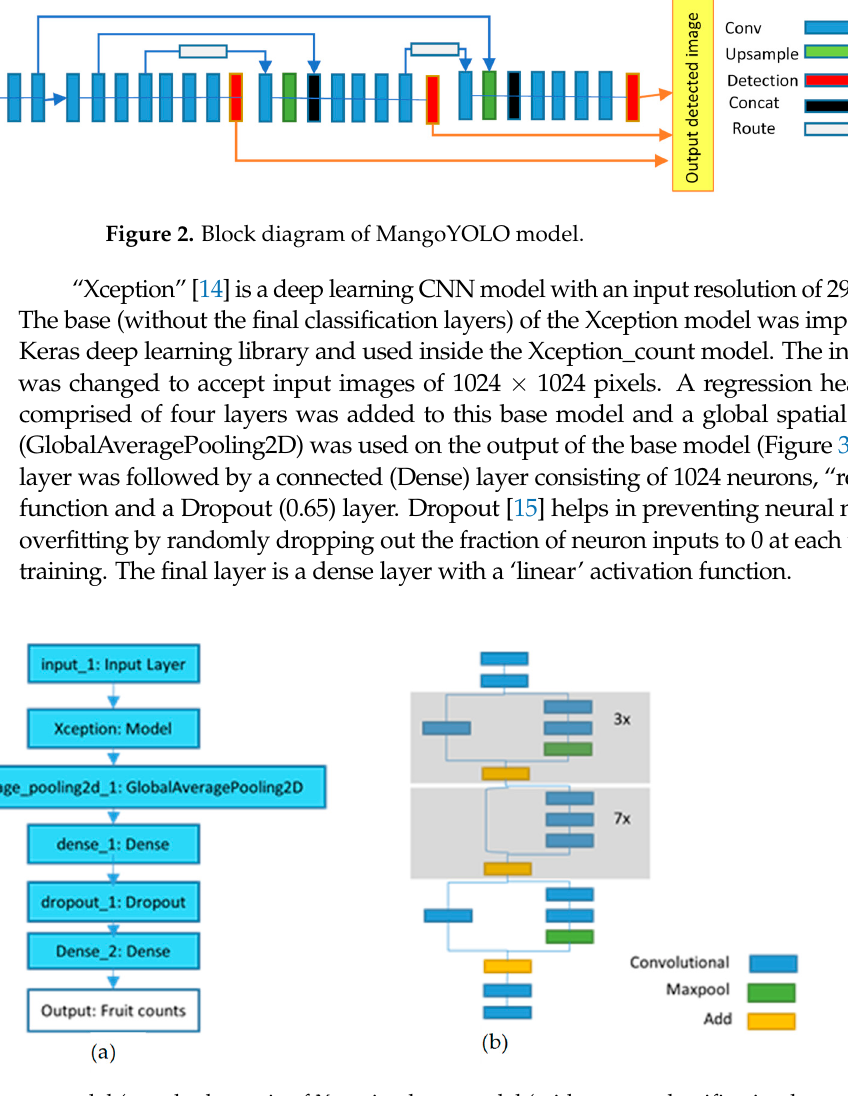
Figure 3. Xception_count model ( a and schematic of Xception base model (without top classification layers) ( b ).